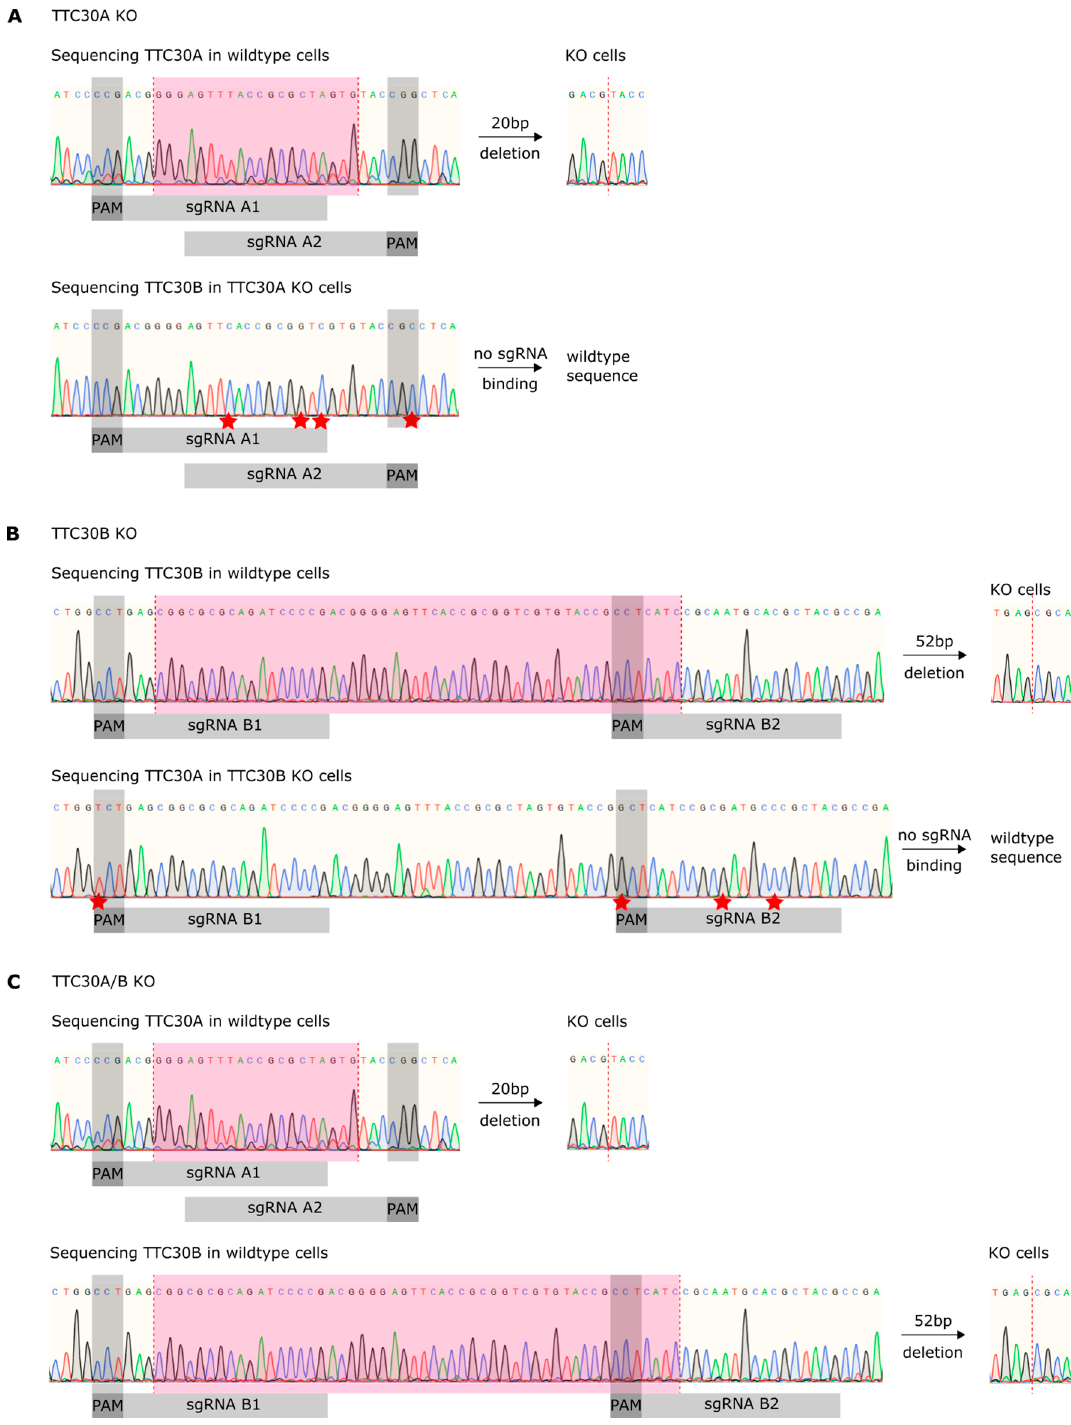
Figure 1. Shown are fragments of wildtype TTC30A/B genes along with PAM sequences (dark grey), sgRNA binding sites (light grey) and deleted base pairs (magenta) and sequencing results after CRISPR/Cas9-mediated KO generation. Sequence mismatches of sgRNAs are highlighted with red stars. ( A ) CRISPR/Cas9-mediated homozygous 20 bp deletion led to a premature stop codon. Specific TTC30A sgRNAs do not bind in the TTC30B gene, resulting in a specific KO. ( B ) CRISPR/Cas9-mediated homozygous 52 bp deletion led to a premature stop codon. Specific TTC30B sgRNAs are non-binding in TTC30A, resulting in a specific KO. ( C ) Mixing TTC30A and B specific sgRNAs resulted in homozygous TTC30A and B double KO.